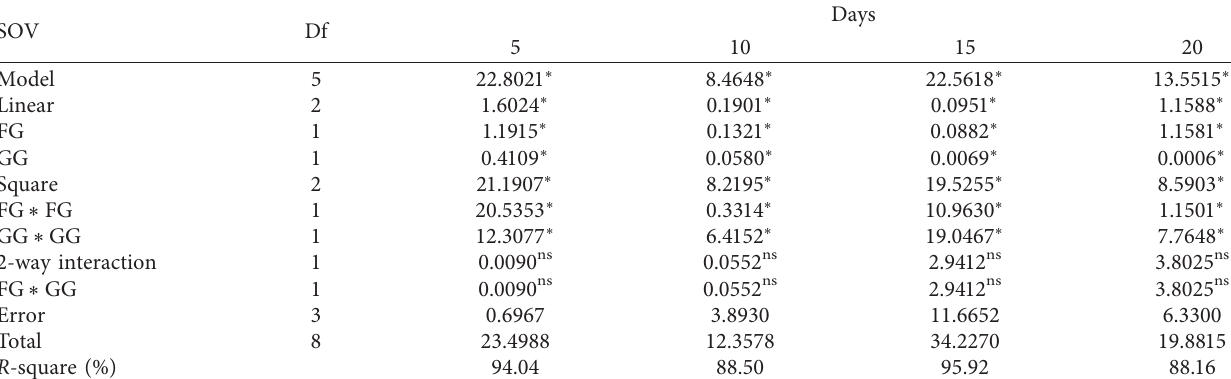
Table 3: Analysis of variance (sum of the square) for response surface model of weight loss of guava fruits during storage.